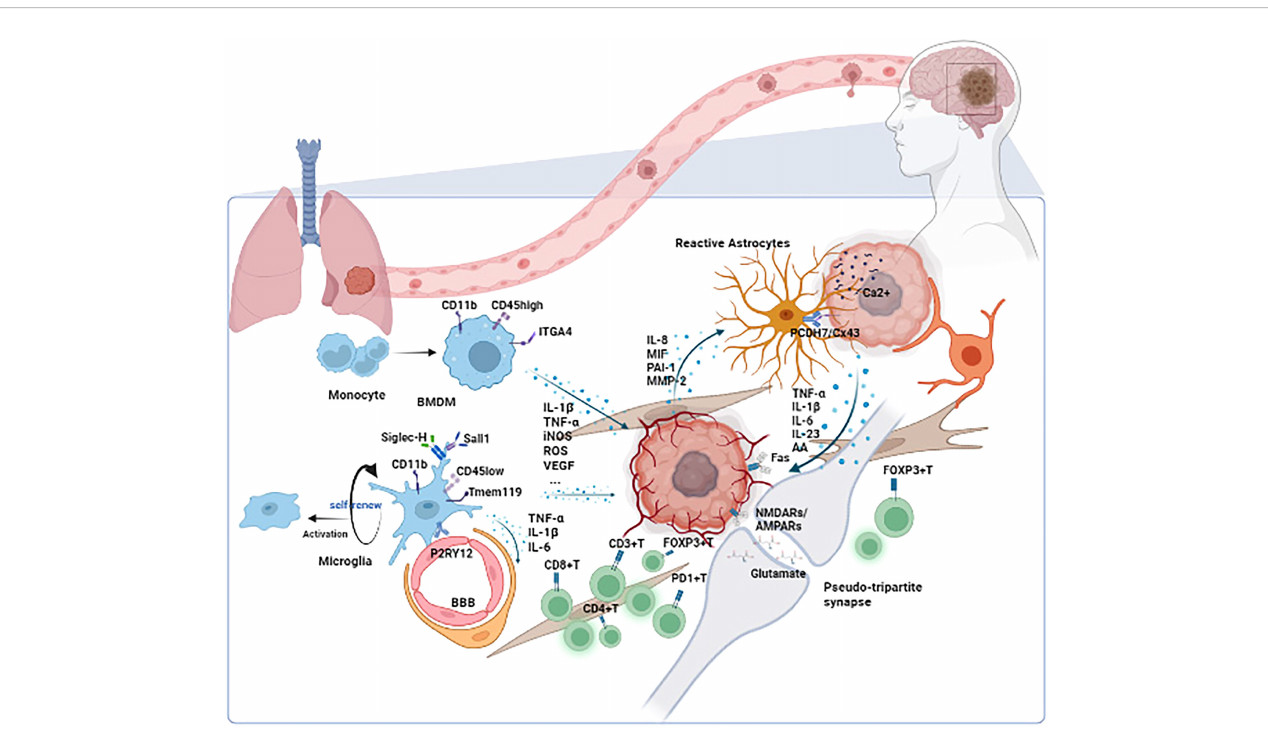
FIGURE 1 The scenario of TIME in BM. Microglia/BMDMs are the main macrophages in TIME of BM. Depending on the status of microglia/BMDMs, different cytokines such as IL-1 b , TNF- a , and VEGF are secreted to in fl uence the development of tumors. Astrocytes play their role through the paracrine cytokine signaling loops and direct contacts such as the PCDH7/Cx43 interaction. The tumor could also utilize the synapse between neuron and tumor to promote its development. Other cells such as lymphocytes, oligodendrocytes, fi broblasts, pericytes, and endothelial cells also function in TIME. TIME, tumor immune microenvironment; BM, brain metastasis; ITGA4, integrin subunit alpha 4; BMDM, bone marrow-derived macrophage; Siglec-H, sialic acid-binding immunoglobulin-like lectin H; Tmem 119, transmembrane protein 119; P2RY12, purinergic receptor P2Y, G-protein coupled, 12; BBB, blood – brain barrier; IL- 1 b , interleukin 1 b ; TNF- a , tumor necrosis factor a ; iNOS, inducible nitric oxide synthase; ROS, reactive oxygen species; VEGF, vascular endothelial growth factor; IL-6, interleukin 6; IL-8, interleukin 8; MIF, migration inhibitory factor; PAI-1, plasminogen activator inhibitor-1; MMP-2, matrix